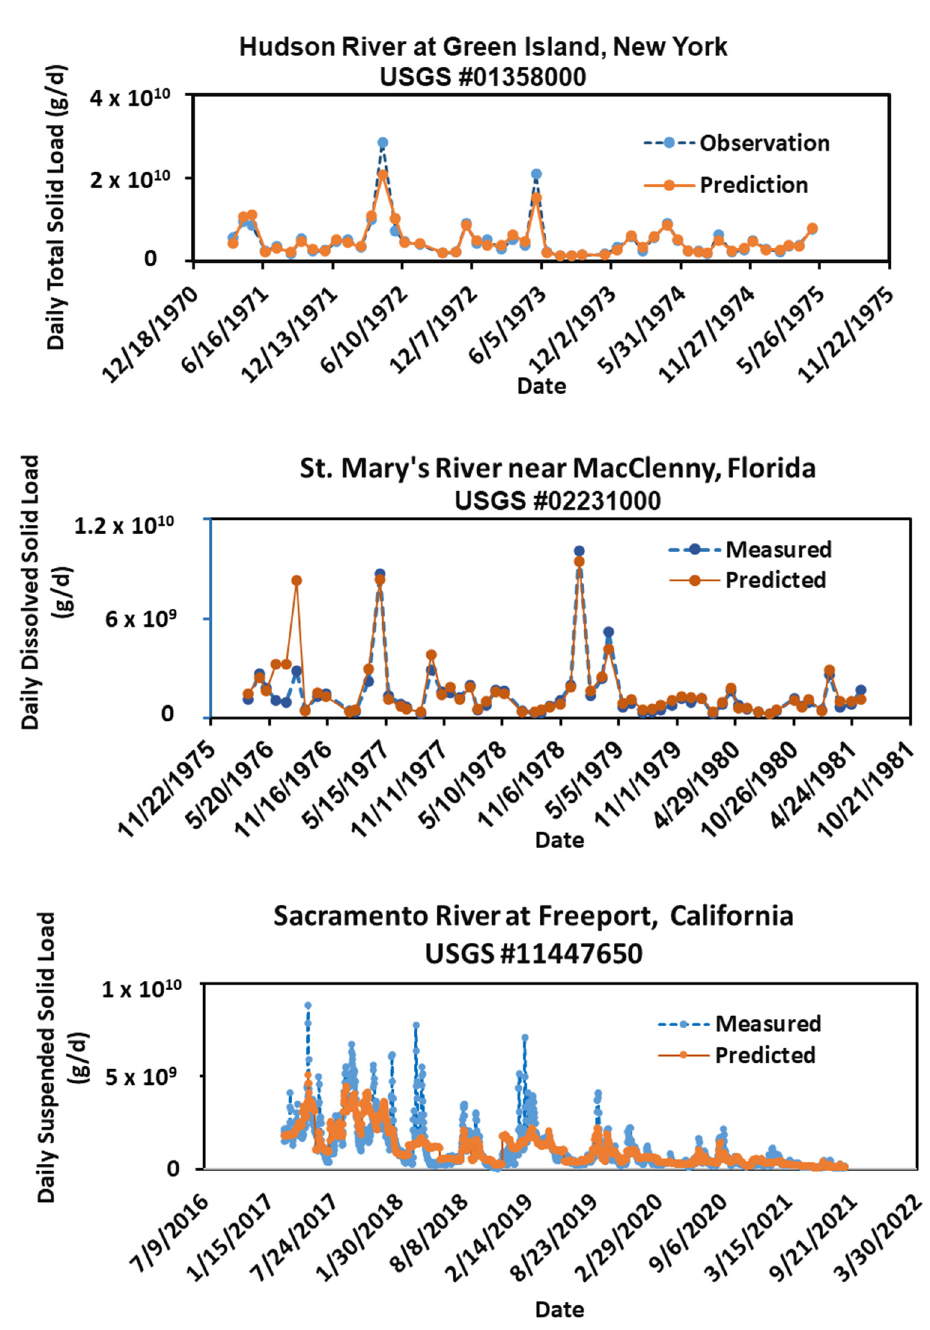
Figure 4. Comparisons of the daily sediment loads between the method predictions and the field measurements for Stations #013580003500, #02231000, and #11447650.